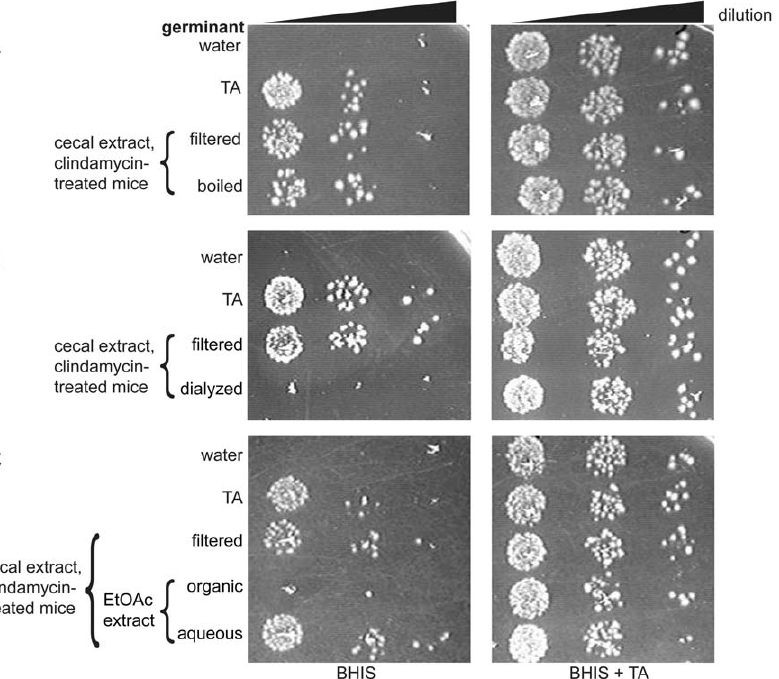
Figure 2. Investigation of properties of the germination factor. Cecal extracts from clindamycin-treated mice were A ) boiled for 10 min., B ) dialyzed against H 2 O in a 1 kDa membrane, or C ) extracted with ethyl acetate (EtOAc) and were tested as in Fig. 1.